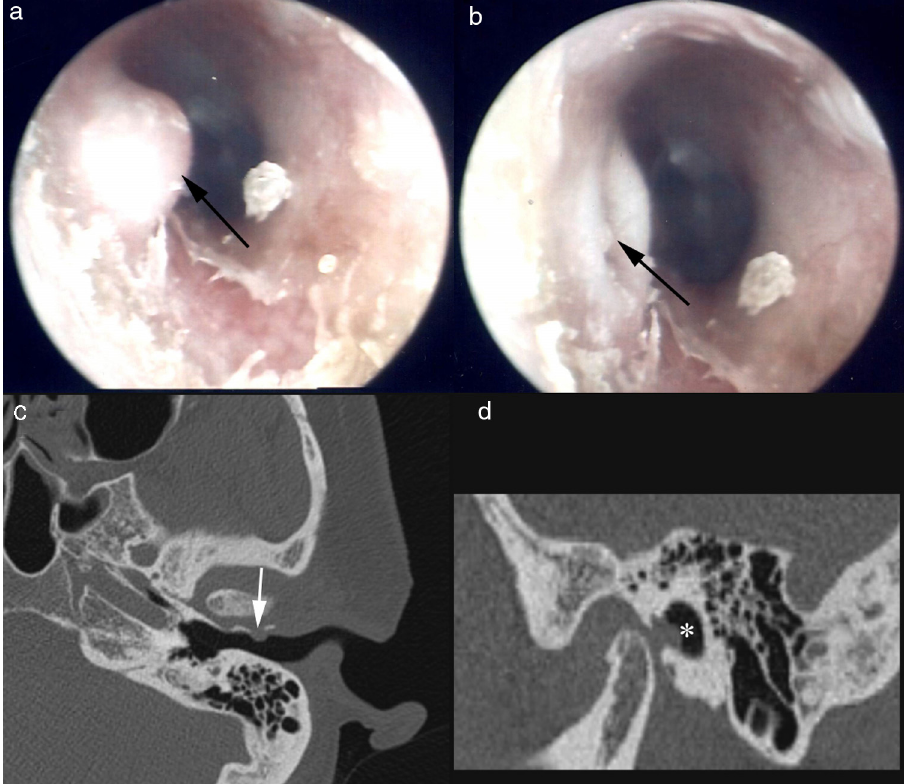
Figure 1 Otoendoscopic findings showing the protrusion as a dome-shaped mass when the mouth was closed (a), and retracted when the mouth was open (b). The axial (c) and sagittal (d) high-resolution computed tomography showed a bone defect of the anterior wall of the external auditory canal (arrow) with herniation of soft tissue material (asterisk).